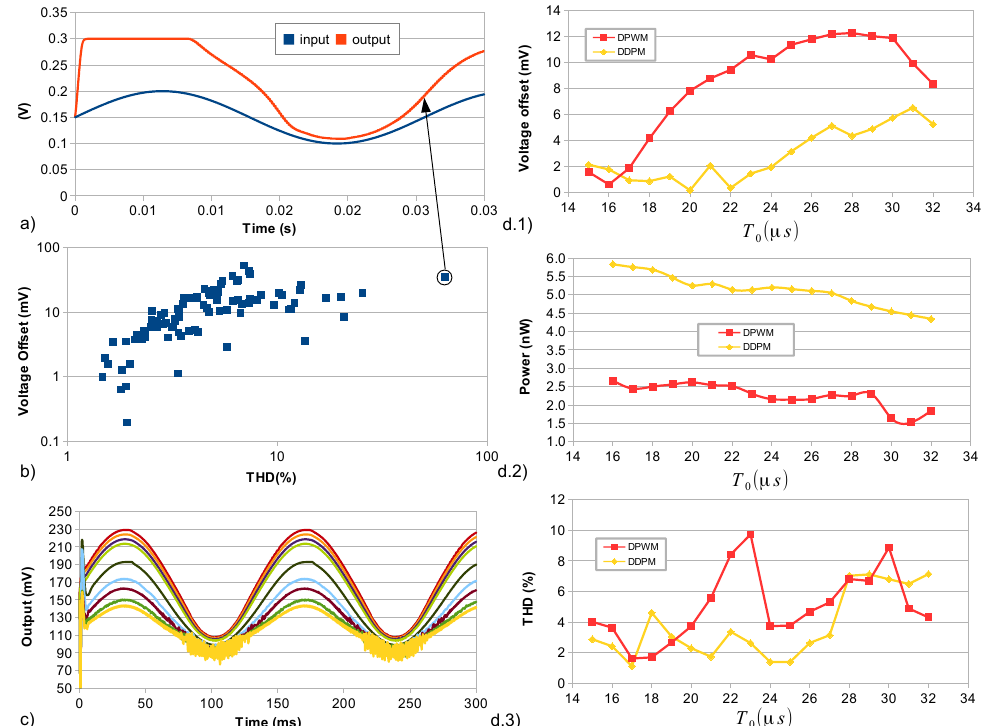
Figure 5. ( a ) V in and V out of a bad sample from the MC analysis with 30 Hz frequency, 50 mV peak amplitude and C out = 80pF ( b ) Thumbnail plot between THD (%) and Voltage offset (mV)—each point is a sampe of the MC simulation ( c ) Changing the BD-OTA offset through DDC using the DPWM modulator ( d.1 , d.2 , d.3 ) Trade-off between power and signal integrity (THD) versus T 0